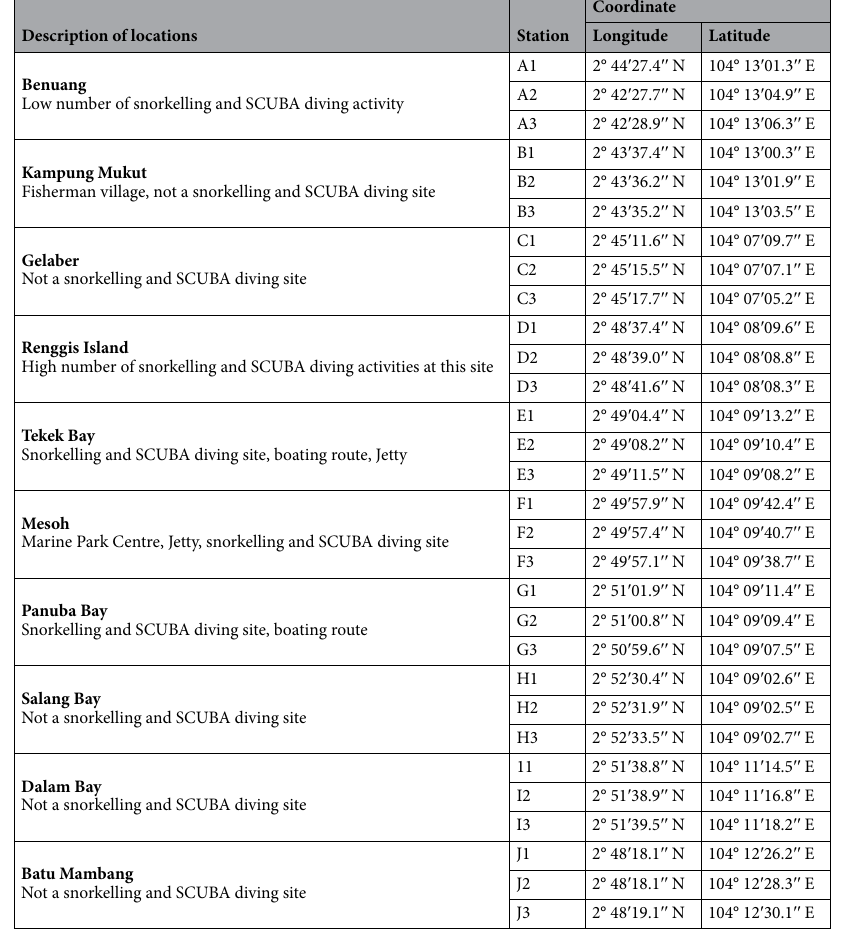
Table 4. Brief description and coordinate of all 30 sampling stations around the coastal waters of Pulau Tioman. All location names are written in bold in the description